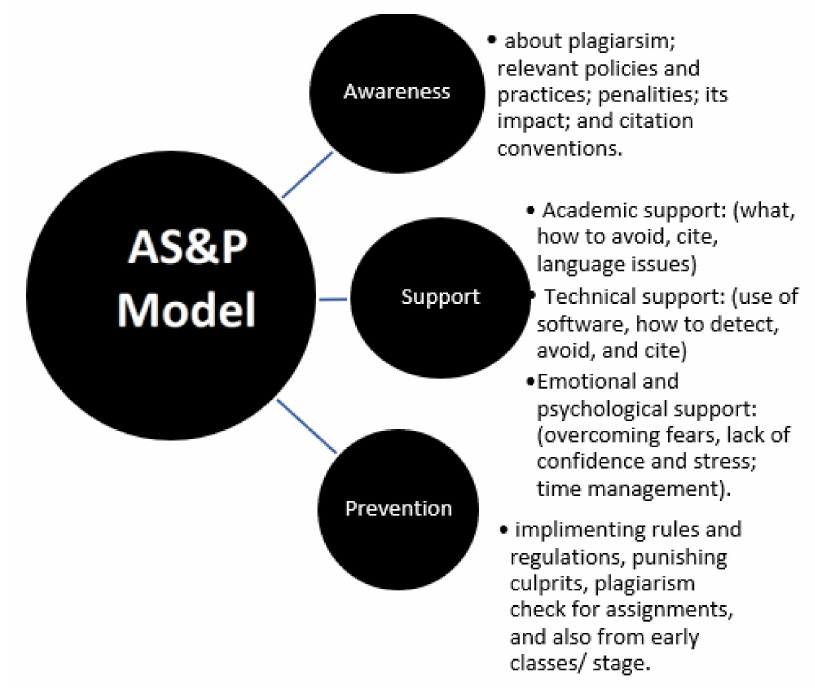
Figure 2. AS&P (Awareness, Support, and Prevention)